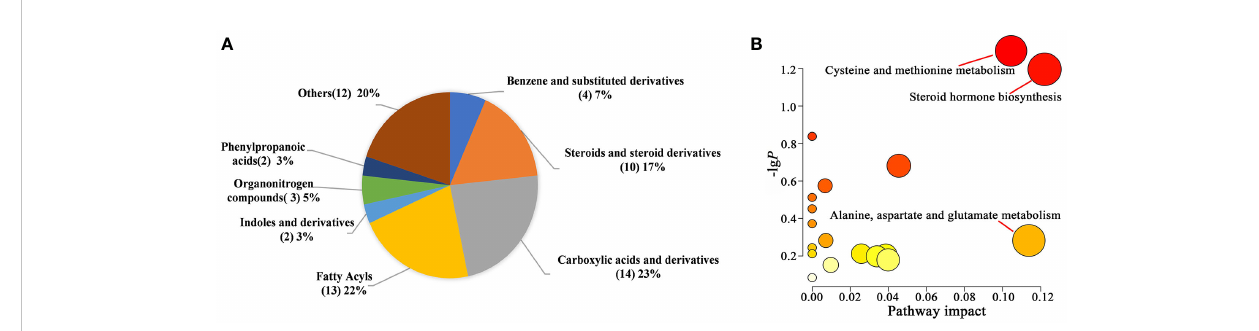
FIGURE 6 Differential metabolite analysis between the two groups. (A) Pie chart of HMDB subclass compounds. The different colors in each pie represented different HMDB classi fi cations, and the area represented the relative proportion of metabolites in the classi fi cation. The number in the brackets represented the amount of corresponding metabolite class. (B) Pathway analysis of signi fi cantly altered metabolites.